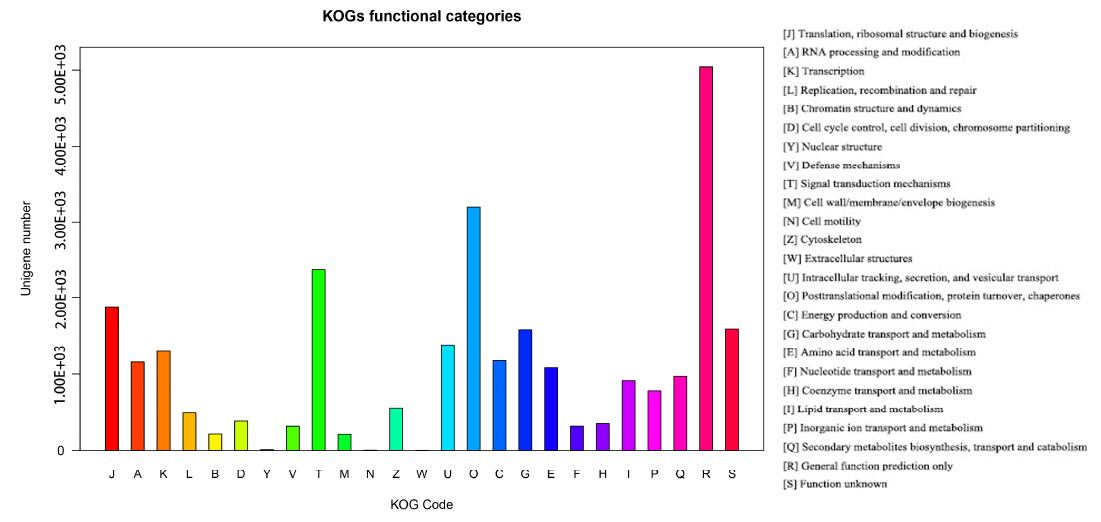
Figure 3. KOG functional classification of Styrax japonicus unigenes. The y-axis indicates the amount of unigenes in a specific functional cluster. The x-axis shows function class.